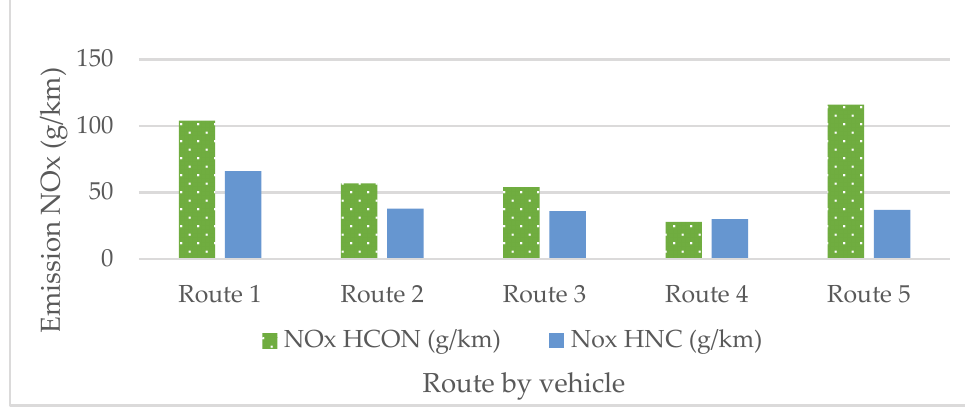
Figure 9. NO X emission in HCON and HNC.